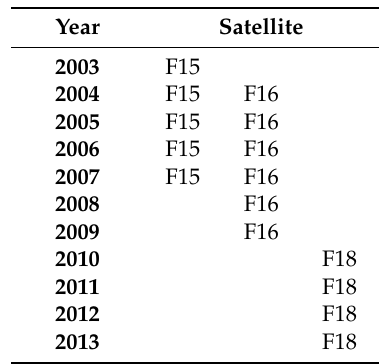
Table 1. Annual composites produced.